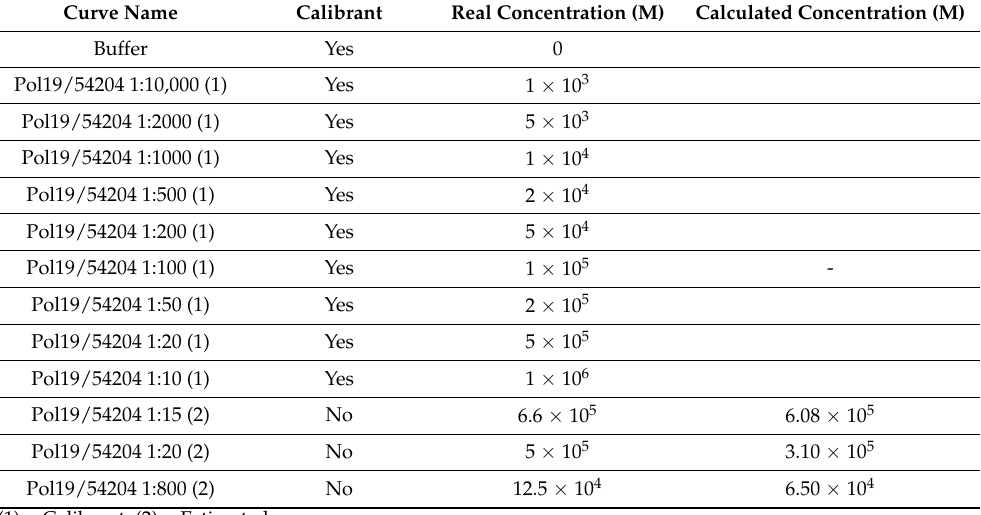
Table 4. Results of the concentration through calibration (CTC) analysis on ASFV Pol19/54204